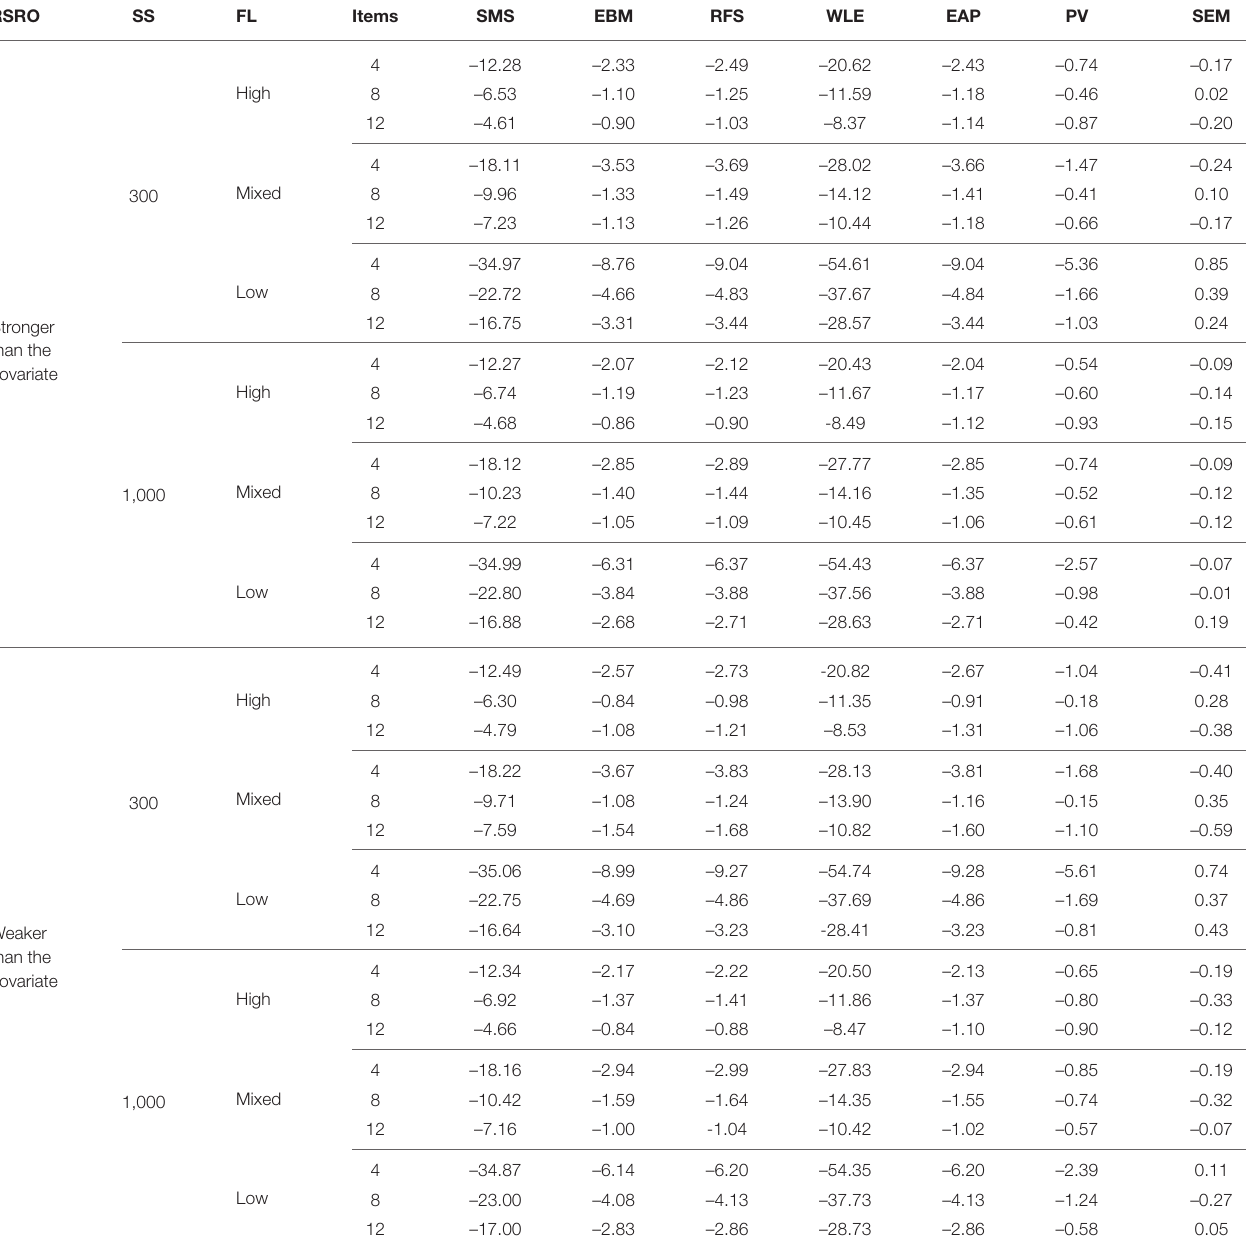
TABLE 6 | Mean percentage bias of regression coefficient of the skill for different approaches for each condition.